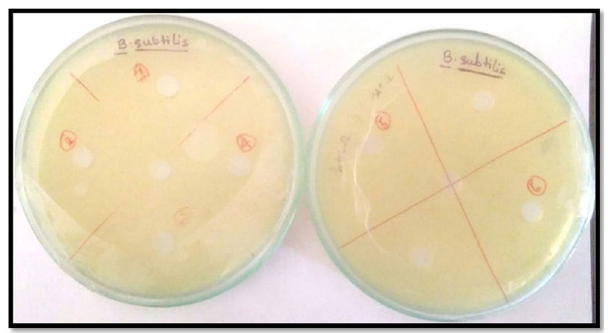
Figure 20. Antimicrobial activity analysis α -CD, β -CD on Gram-positive B. subtilis by Agar Cup method. No zone of inhibition is observed. Double distilled water is taken as the control. [Marker points (red) for the verified samples taken in the plates (1. SNP, 2. PEHB, 3. PEHA, 4. SNPA, 5. PEH, 6. SNPB) and Marker points (black) for the model organism taken in the